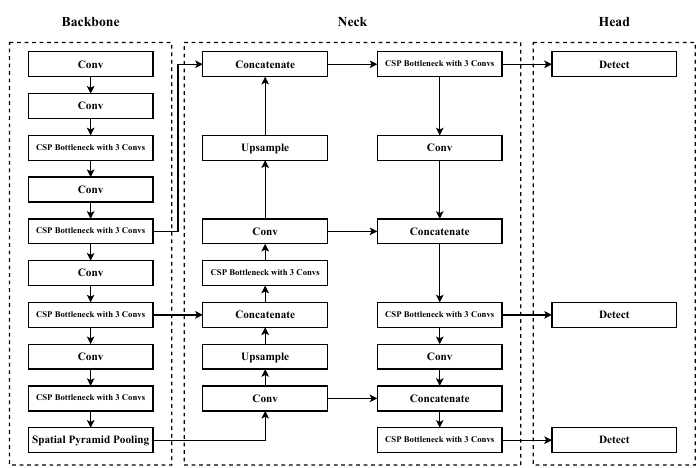
Figure 5. Overview of the structure of